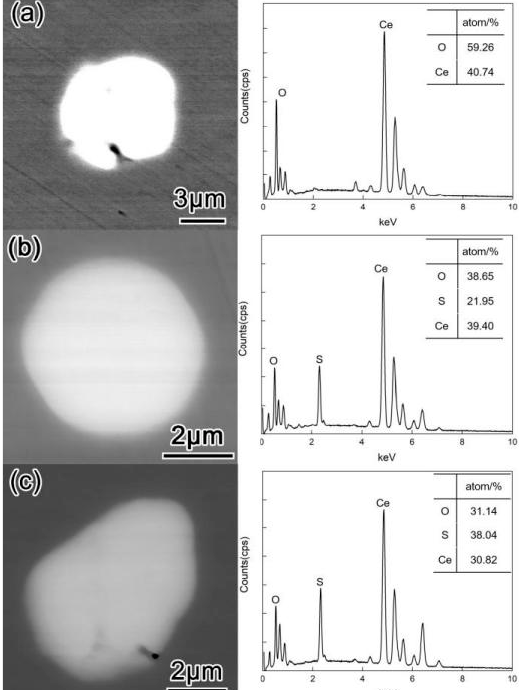
Figure 6. Morphology of typical inclusions in steel after reaction with Ce for 30 min (T3): ( a ) L–Ce;